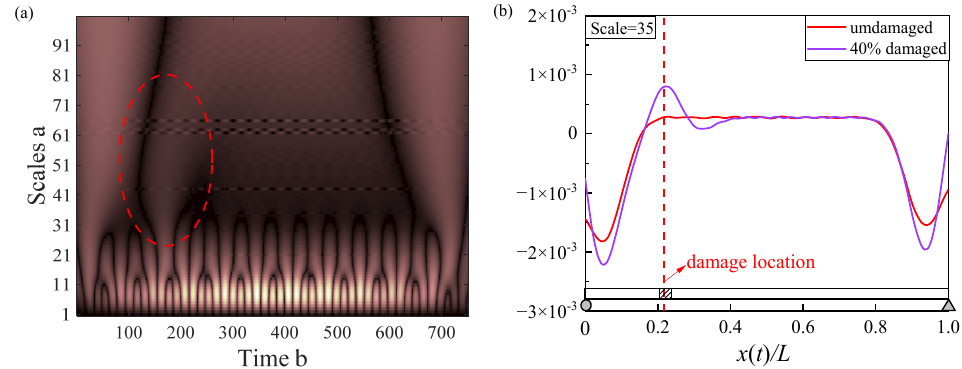
Figure 5. CWT of vehicle acceleration under case 5: ( a ) the time ‐ frequency diagram; ( b ) wavelet coefficient graph with a scale factor of 35.